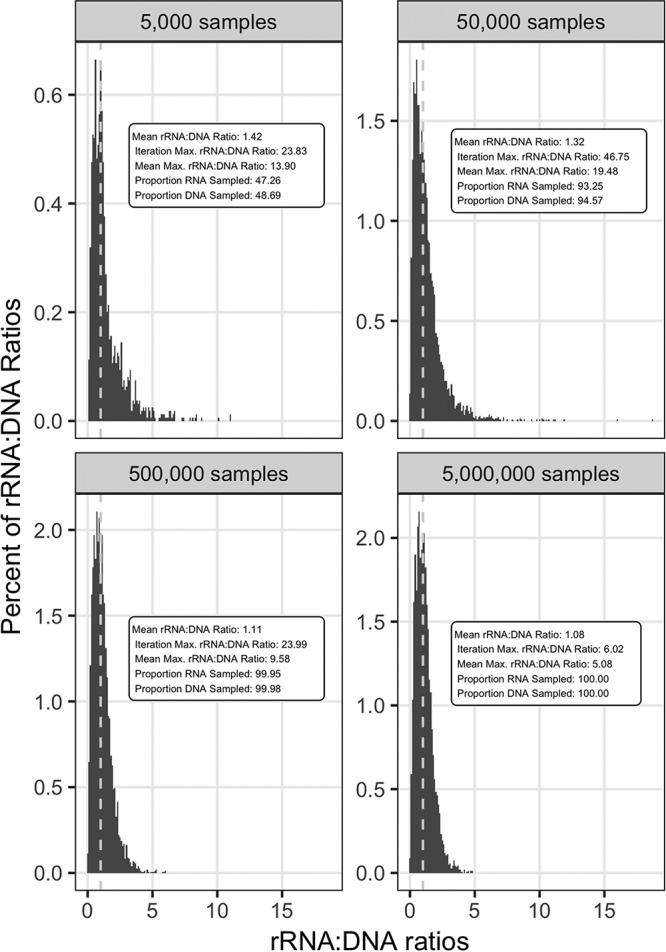
Effects of partial sampling on rRNA/DNA ratios. Each panel represents a different sampling depth, ranging from random samples of 1 to 1,000 times the input population richness. The simulation data presented are for a lognormal σ1 community structure with the medium rRNA amplification model and 5,000 populations. Data from other model permutations were qualitatively similar (data not shown). Each histogram represents illustrative data from a single run of a simulation. Summary statistics of combined data from 100 independent runs are included in the insets. The reported proportions of RNA and DNA sampled refer to the average proportions of the 5,000 input taxa that were detected in the samples.